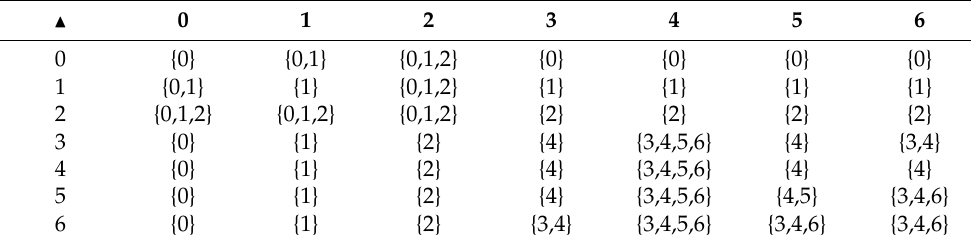
Table 9. The binary hypergroupoid ( C , (cid:78) ).